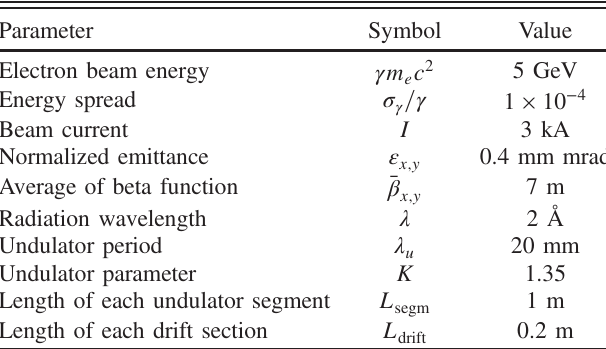
TABLE I. Parameters of the steady-state